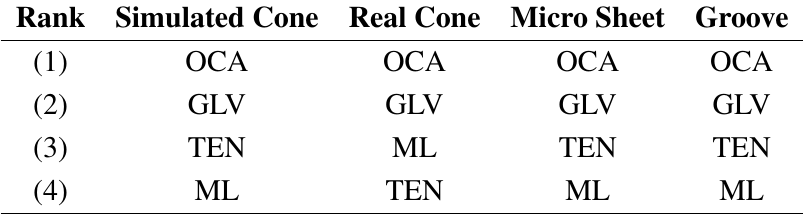
Table 6. Overall rank table of each focus measure with various